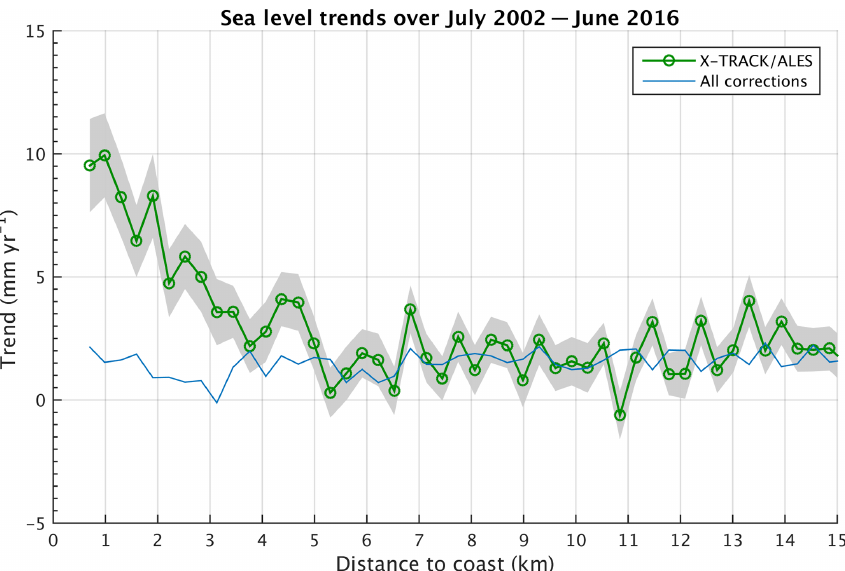
Figure 4. Altimetry-based sea level trends over July 2002–June 2016 around Senetosa against the distance to the coast. Shaded area corre- sponds to the trend uncertainty range. The light blue curve is the sum of trends in individual corrections.